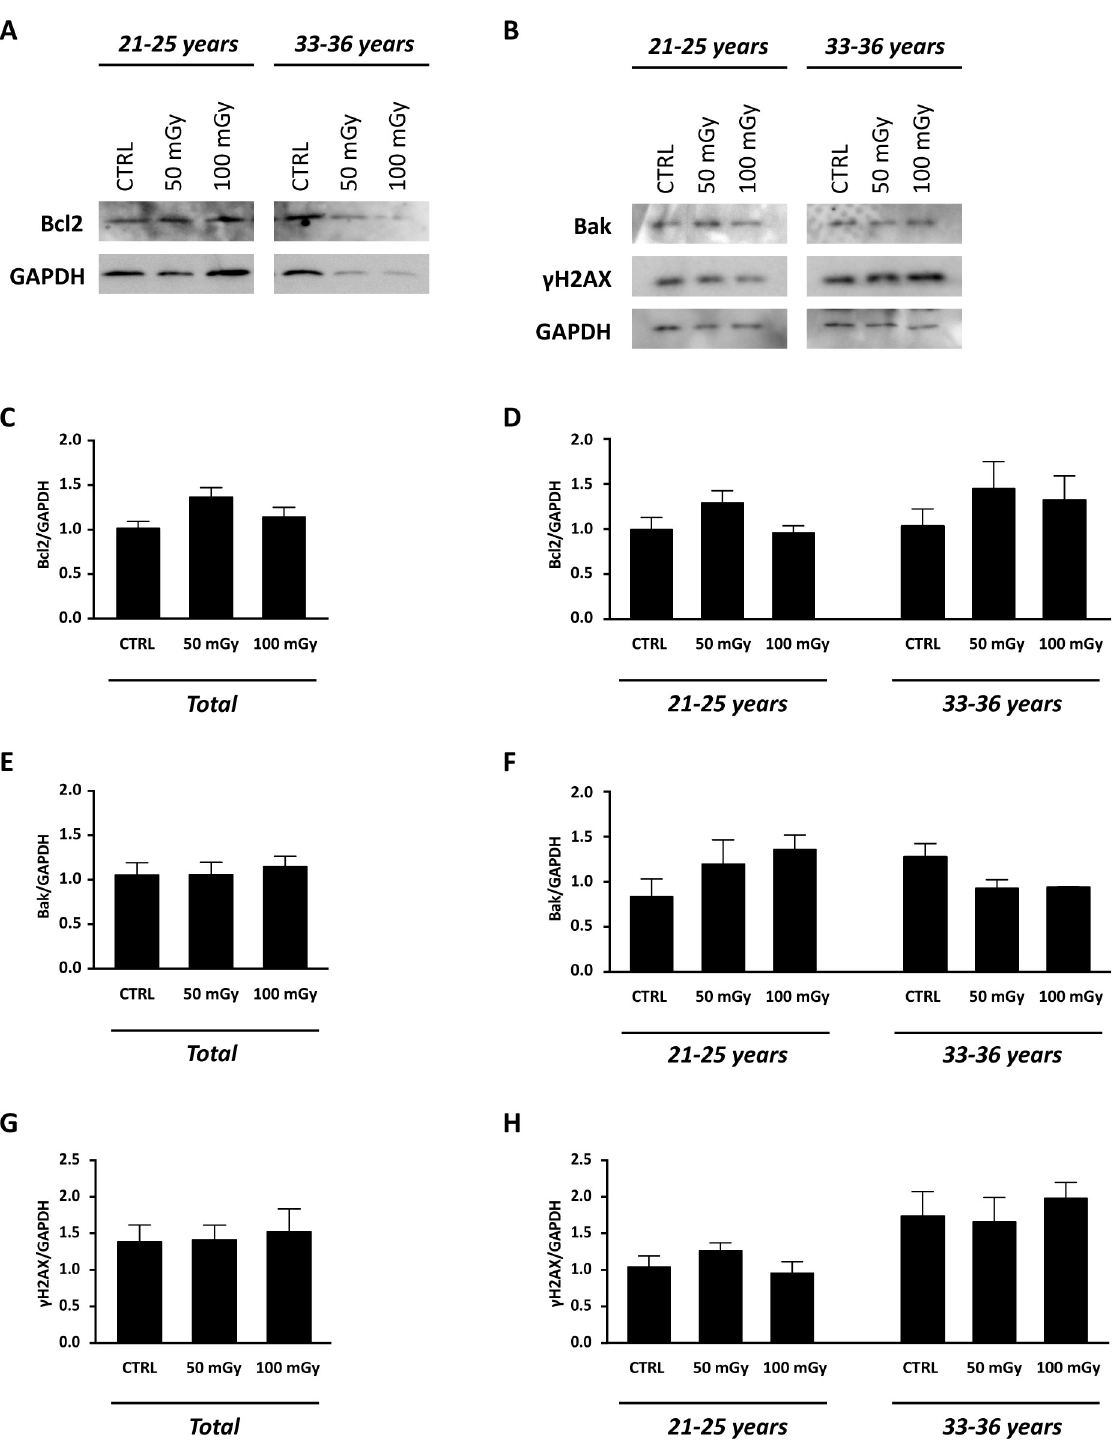
Fig 9. Apoptosis evaluation in the human ovarian tissue exposed to X-radiation (50 mGy and 100 mGy). (A, B) Representative WB for Bcl2 (A), Bak and γ H2AX (B) in 21–25 years and in 33–36 years groups. (C-H) Densitometric quantification of the relative expression of Bcl2, Bak and γ H2AX normalized against GAPDH reported as (C, E, G) combined data from ovarian cortex derived from all 6 patients or (D, F, H) organised by patients’ age. Data are expressed as mean ± SEM. ANOVA of 50 mGy and 100 mGy groups vs control: not significant. CTRL: human ovarian tissue not exposed to